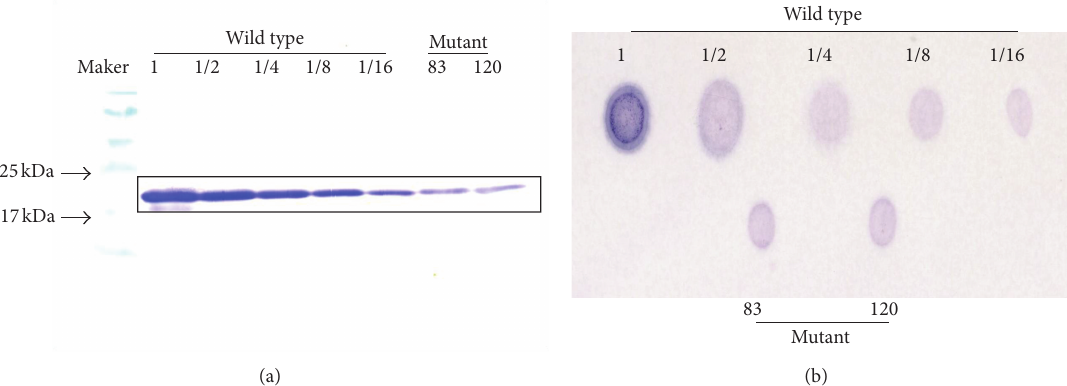
Figure 2: (a) The result of western blotting analysis for wild type, Tyr83BFLAF and Trp120BFLAF mutant streptavidins. BFLAF was position- specifically incorporated into streptavidin by using a CGGG four-base codon. The bands of the wild and mutant streptavidins were observed around 20 kDa. (b) The result of dot blotting. The biotin binding activities of these fluorescent mutant streptavidin were evaluated by a dot blot analysis using an alkaline phosphatase-labeled biotin. The protein amounts of Tyr83BFLAF and Trp120BFLAF mutant streptavidins blotted on the membrane were 15.2% and 14.4% of that of wild type